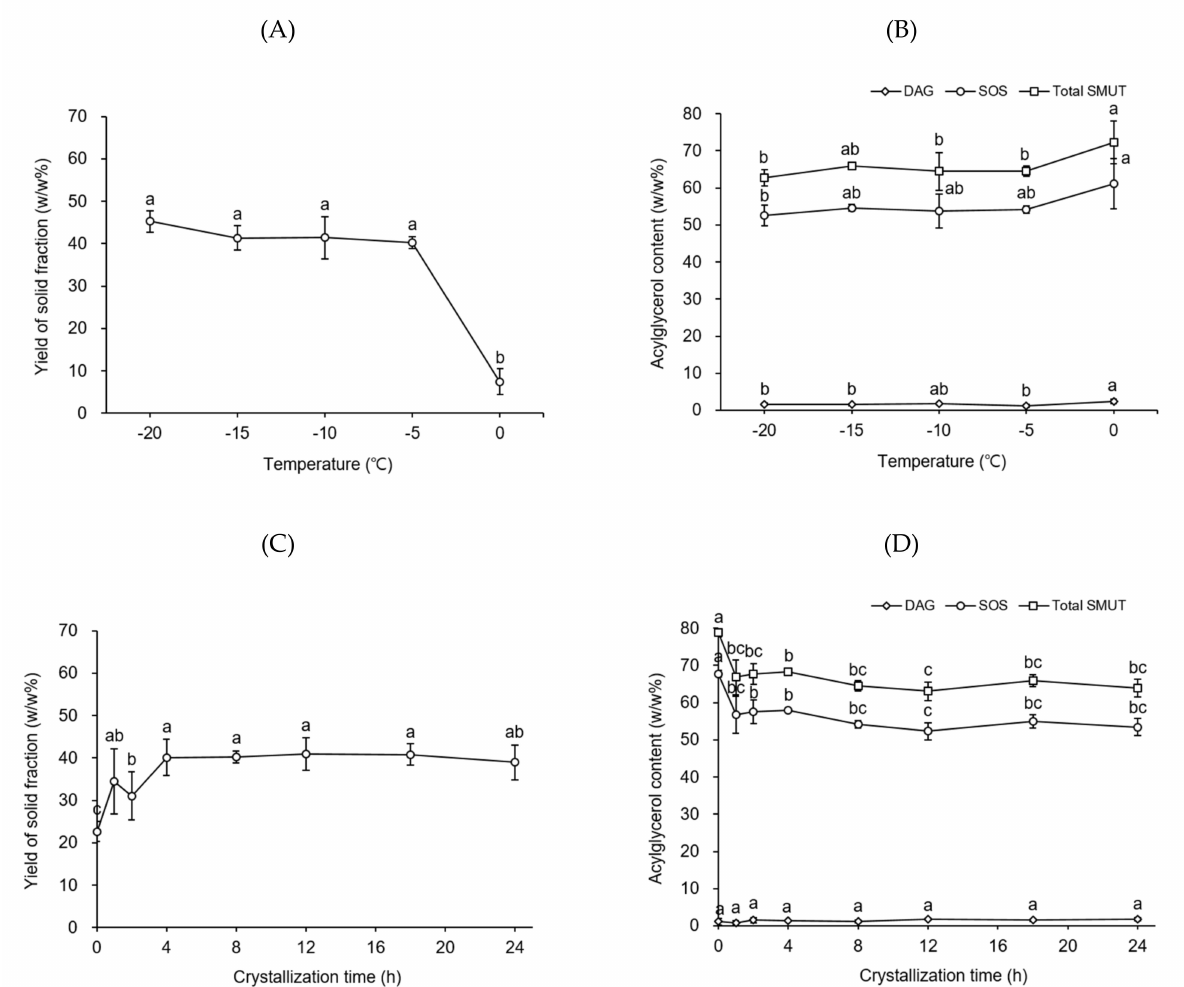
Figure 4. Yield of the solid fraction ( A , C ) and the contents of diacylglycerols (DAGs), 1,3-distearoyl-2-oleoyl glycerol, and total symmetric monounsaturated triacylglycerols (SMUTs) in the solid fraction ( B , D ) obtained by the hexane fractionation of degummed shea butter as a function of temperature and crystallization time, respectively. Fractionation was performed by using 5 g of degummed shea butter in a flat-bottom glass vessel (8 cm × 3.5 cm i.d.). Different letters (a–e) indicate significant differences between samples ( p <